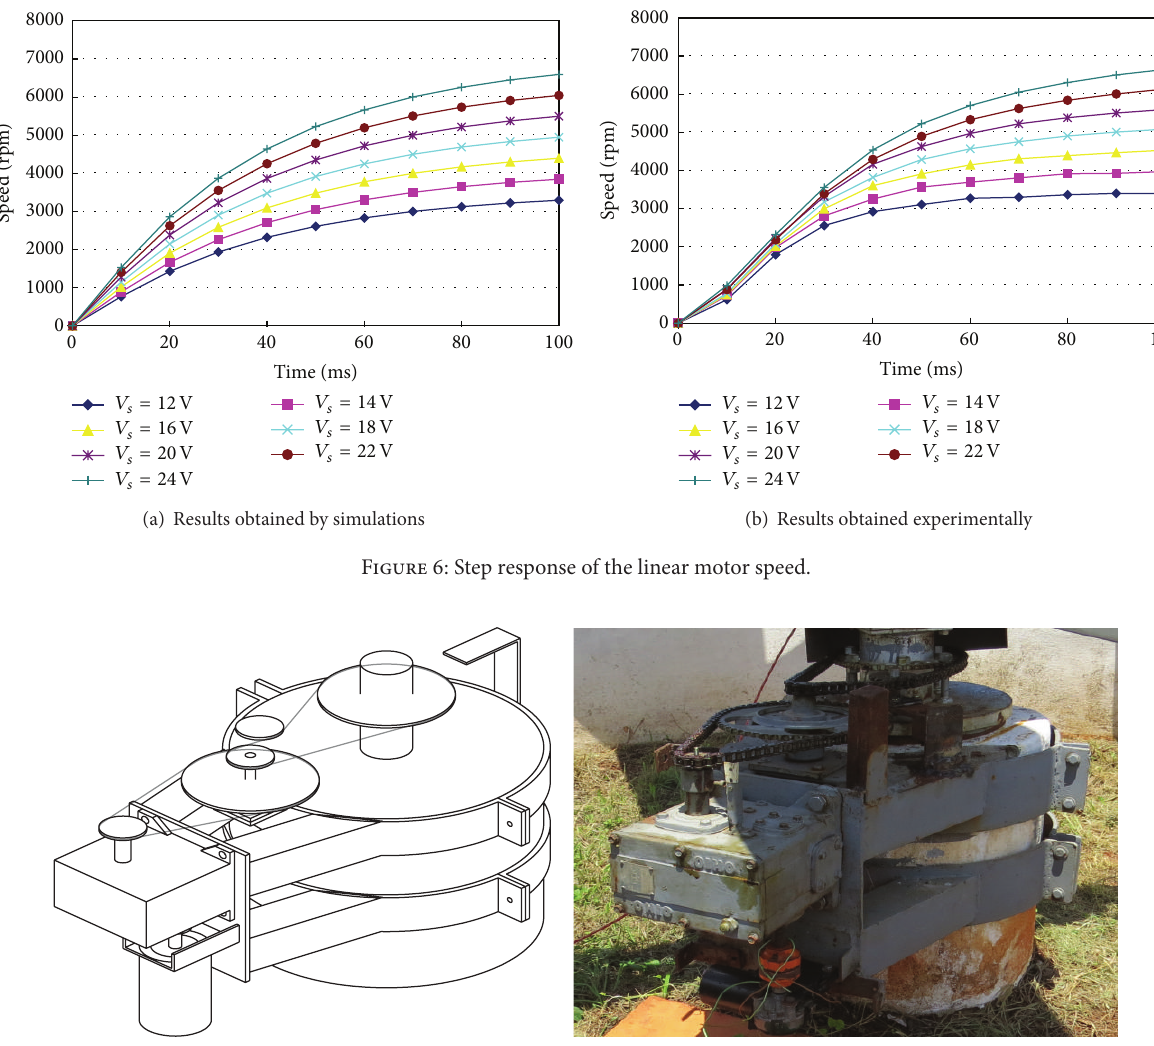
Figure 7: Mechanism of azimuth motion and speed reduction system.